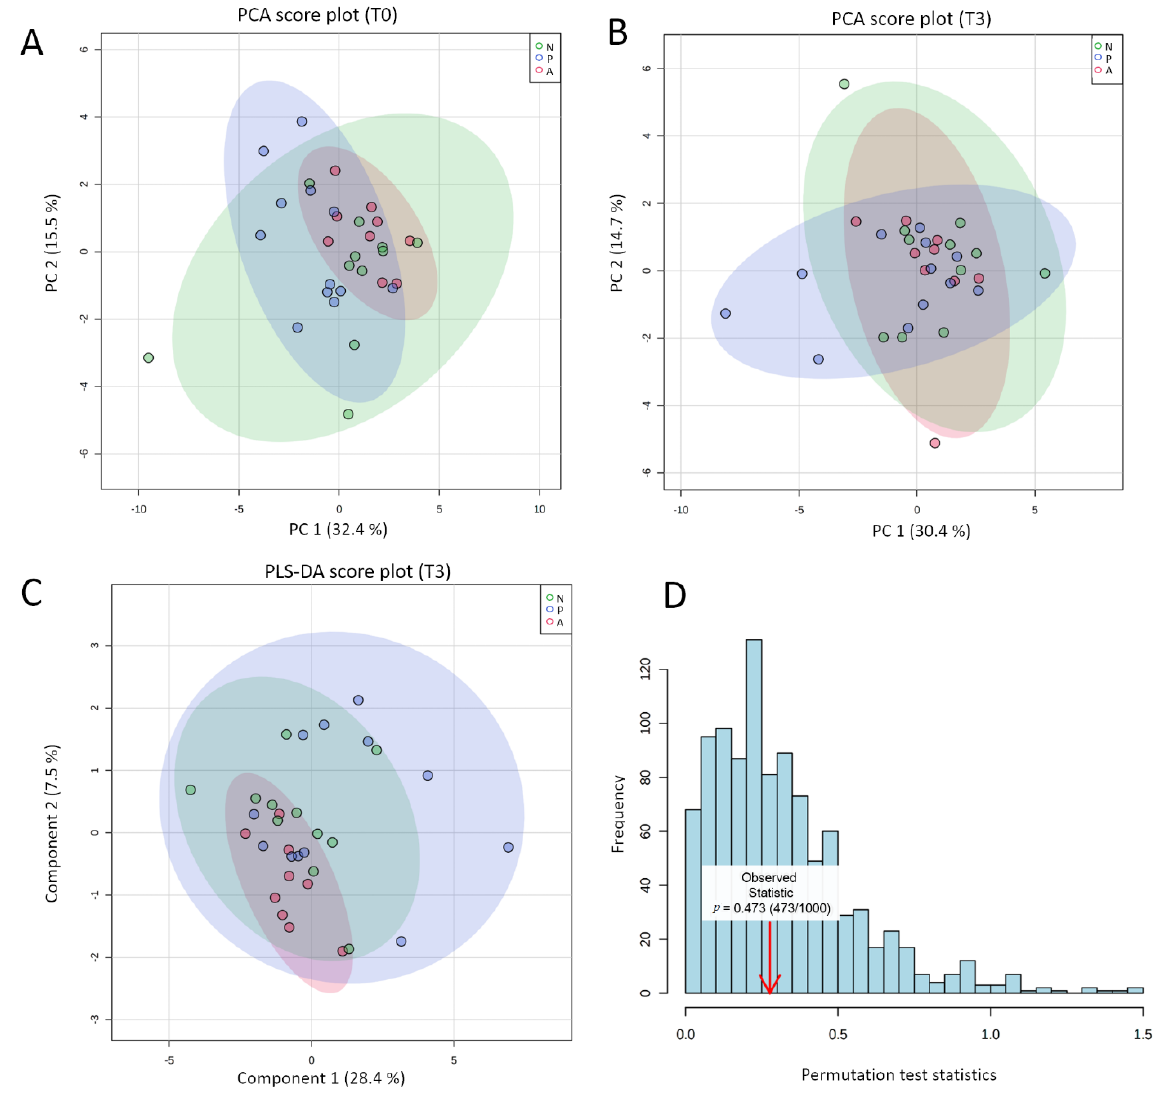
Figure 3. ( A , B ) 2D PCA Score plot for comparison of the global eCBome profile at baseline ( A ) and following the intervention ( B ) according to the group. ( C ) 2D PLS-DA cross-validated score plot for comparison of the global eCBome profile between groups following the intervention (time 3 months). The semi-transparent area is the 95% confidence region for each group. Variance explanation (%) for each PC/component is indicated. Color code: green ellipses correspond to the placebo group; blue ellipses correspond to the pasteurized group; red ellipses correspond to the alive group, with each dot representing one participant. ( D ) Result of the permutation test with separation distance (B/W) select for a statistical test, set permutation numbers: 1000. Analyses and graphs were performed and generated using MetaboAnalyst v4.0 (26/11/2020). Placebo group, n = 11; pasteurized bacteria group, n = 12; alive bacteria group, n = 9. Abbreviations: A, alive; N, non-treated (Placebo); P, pasteurized; PCA, principal component analysis; PC, principal component; PLS-DA; partial least square discriminant analysis; T0, time 0 month ; T3, time 3 months.